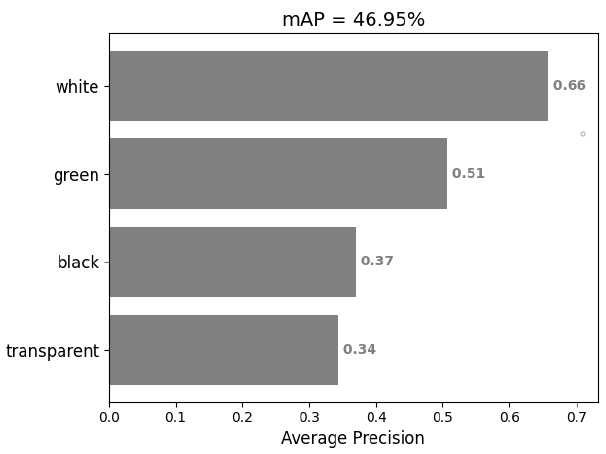
Figure 9. mAP of SSD detection results.